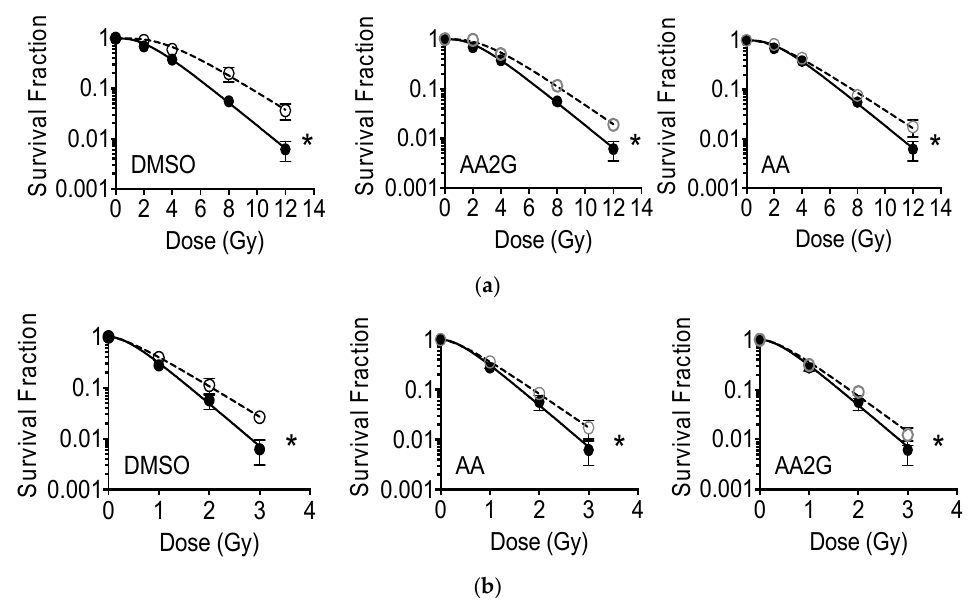
Figure 3. Cell survival curves, cells treated with DMSO, AA, AA2G before gamma-ray exposure. ( a ) CHO10B2 cells; ( b ) xrs5 cells. Closed circle symbols with solid lines indicate non-drug treated control. Open circle symbols with dashed lines indicate data with chemical pre-treatment. Error bars indicate standard error of the means of at least three independent experiments. * indicates statistically significant differences between control and chemical treatment ( F -test, p < 0.05). Table 1. D 10 values and protection ratio of gamma-rays.